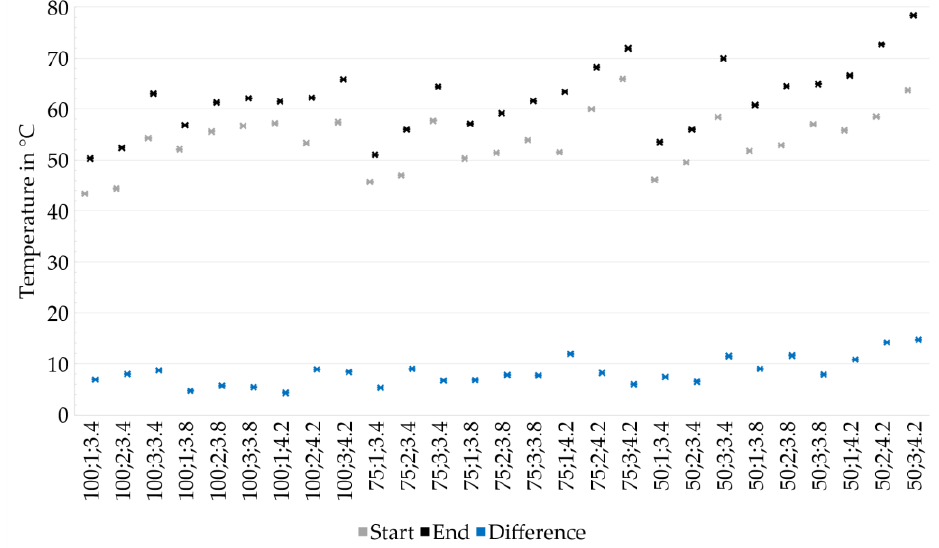
Figure 6. Analysis of temperature increases within the process, measured by the thermocouple. Temperatures increase with decreasing layer heights and increasing drying intensities and drying periods.